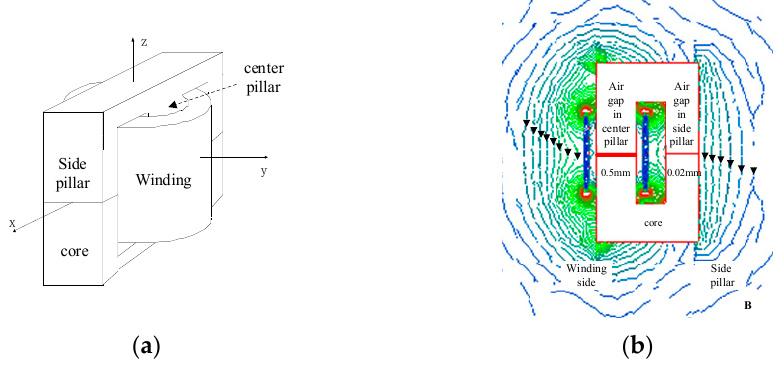
Figure 11. EE shaped inductor ( a ) 3D inductor structure; ( b ) 2D leakage flux distribution.